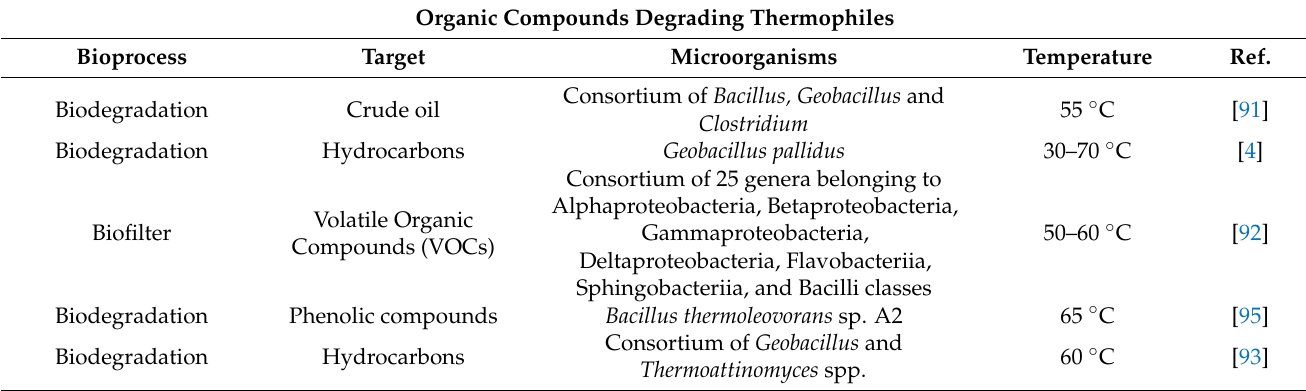
Table 2. Examples of thermophiles exploited in bioremediation processes of organic compounds. Organic Compounds Degrading